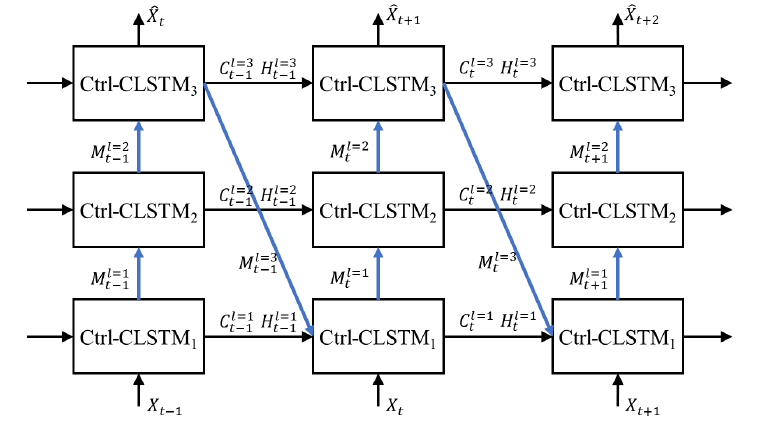
Figure 1. Architecture of